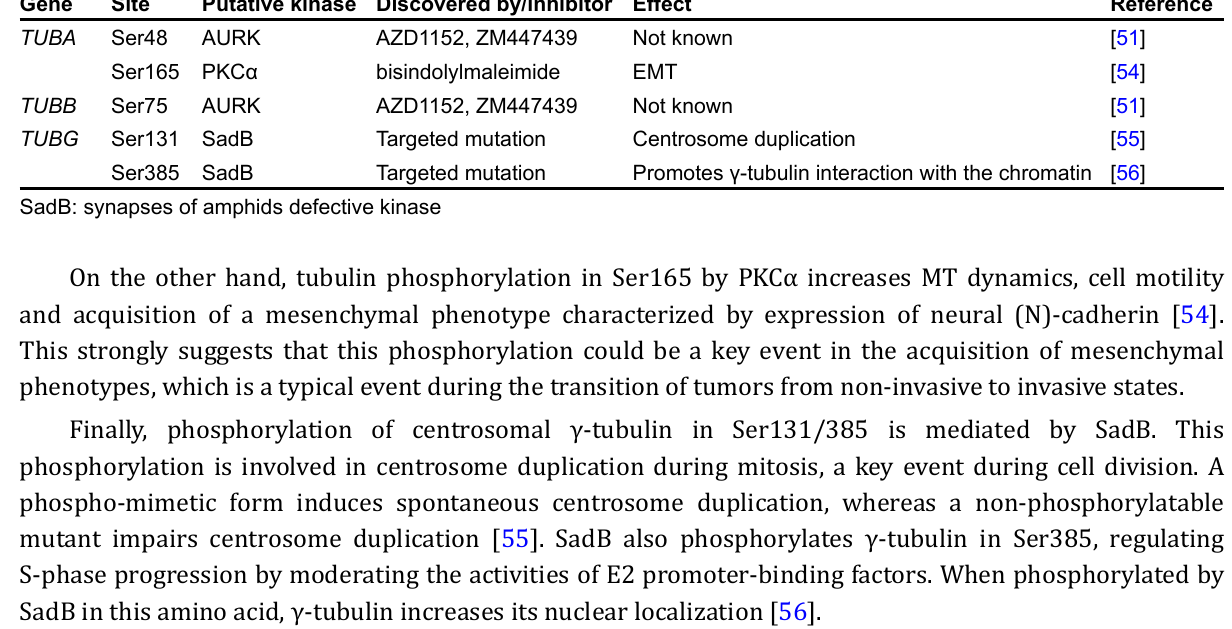
Table 3. Main human tubulin phosphorylation sites